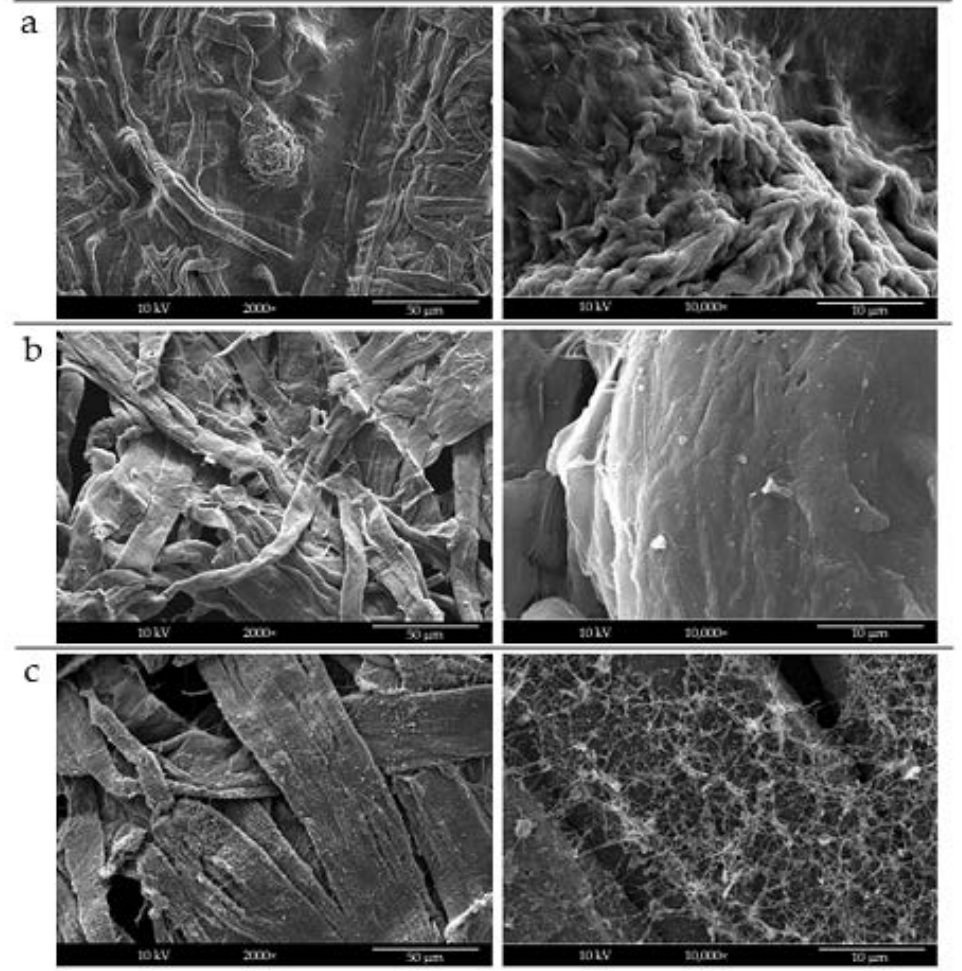
Figure 2. SEM analysis of cellulose tissue decorated with electrosprayed sCNs using different solvent systems: ( a ) distilled water, ( b ) distilled water/acetic acid (50/50 w / w ), and ( c ) distilled water/HFIP (60:40) w / w ). Left column shows zoomed-out (2000 × ), while right column shows zoomed-in (30,000 × )